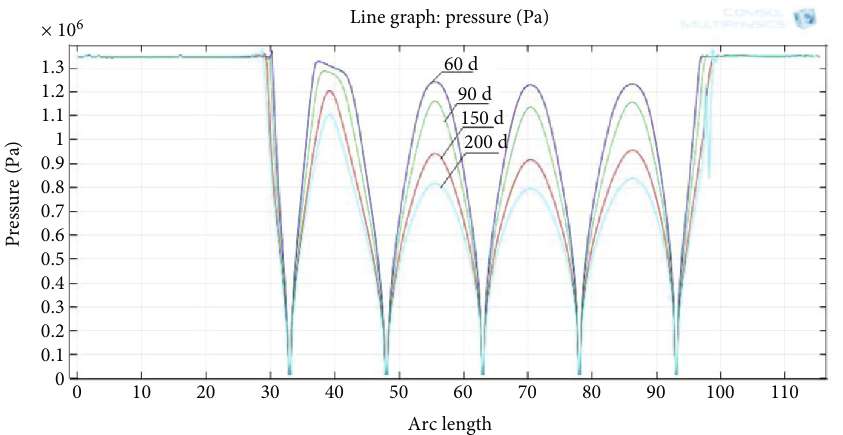
Figure 8: Curve of gas pressure distribution of gas drainage with pressure-relief